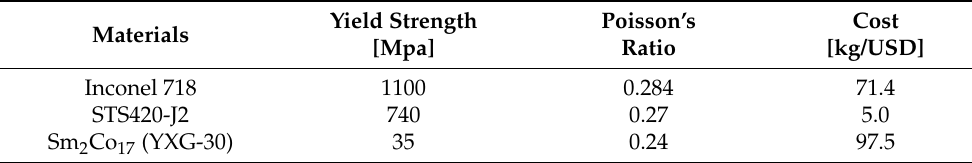
Table 5. Mechanical characteristics and cost depending on the